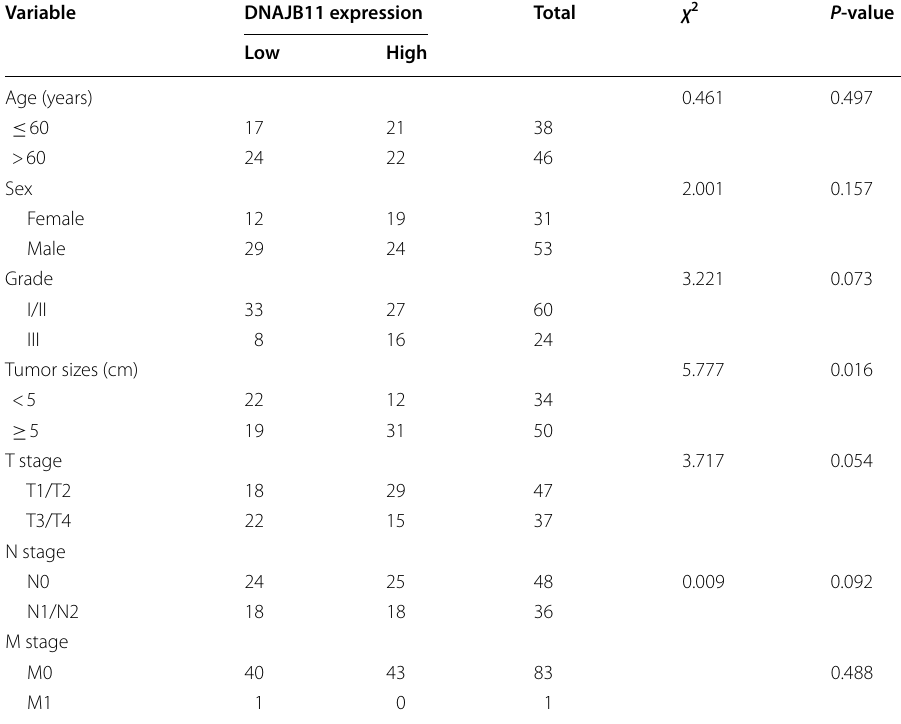
Table 2 Correlation between DNAJB11 expression and clinicopathological characteristics